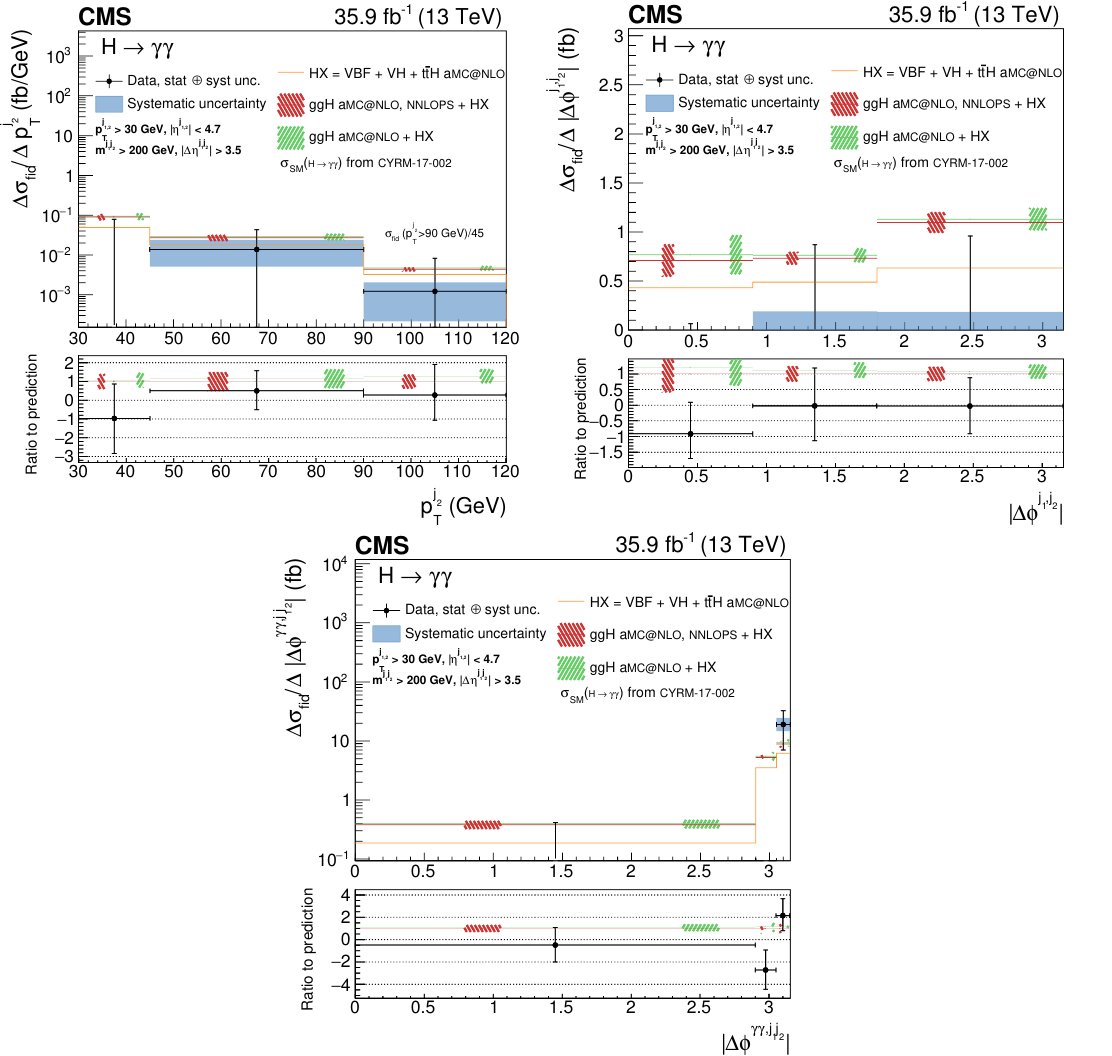
Figure 8 . Measurement in a VBF-enriched region of the (cid:12)ducial phase space of the di(cid:11)erential cross section (black points) as functions of p j 2 , j (cid:1) (cid:30) j 1 ;j 2 j , and j (cid:1) (cid:30) (cid:13)(cid:13);j 1 j 2 j . The error bars indicate T 1 standard deviation uncertainty. The systematic component of the uncertainty is shown by the blue band. The measurements are compared to two di(cid:11)erent simulation programs (histograms) with their uncertainties (hatched areas), both normalized to the same theoretical predictions from ref. [13]. When the last bin of the distribution is an over(cid:13)ow bin, the normalization of the cross section in that bin is indicated in the